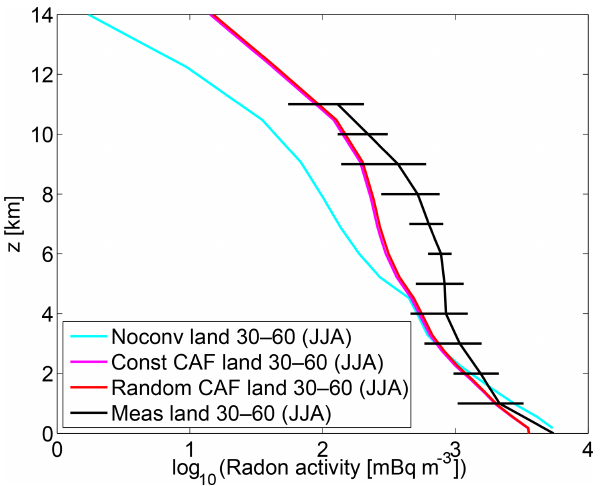
Figure 14. Observed mean radon profile obtained from measure- ments over land (30–60 ◦ N, June–August) by Liu et al. (1984) com- pared to the simulated radon obtained from 15-year long-time runs for the same region and months. Bars show the standard deviation of the